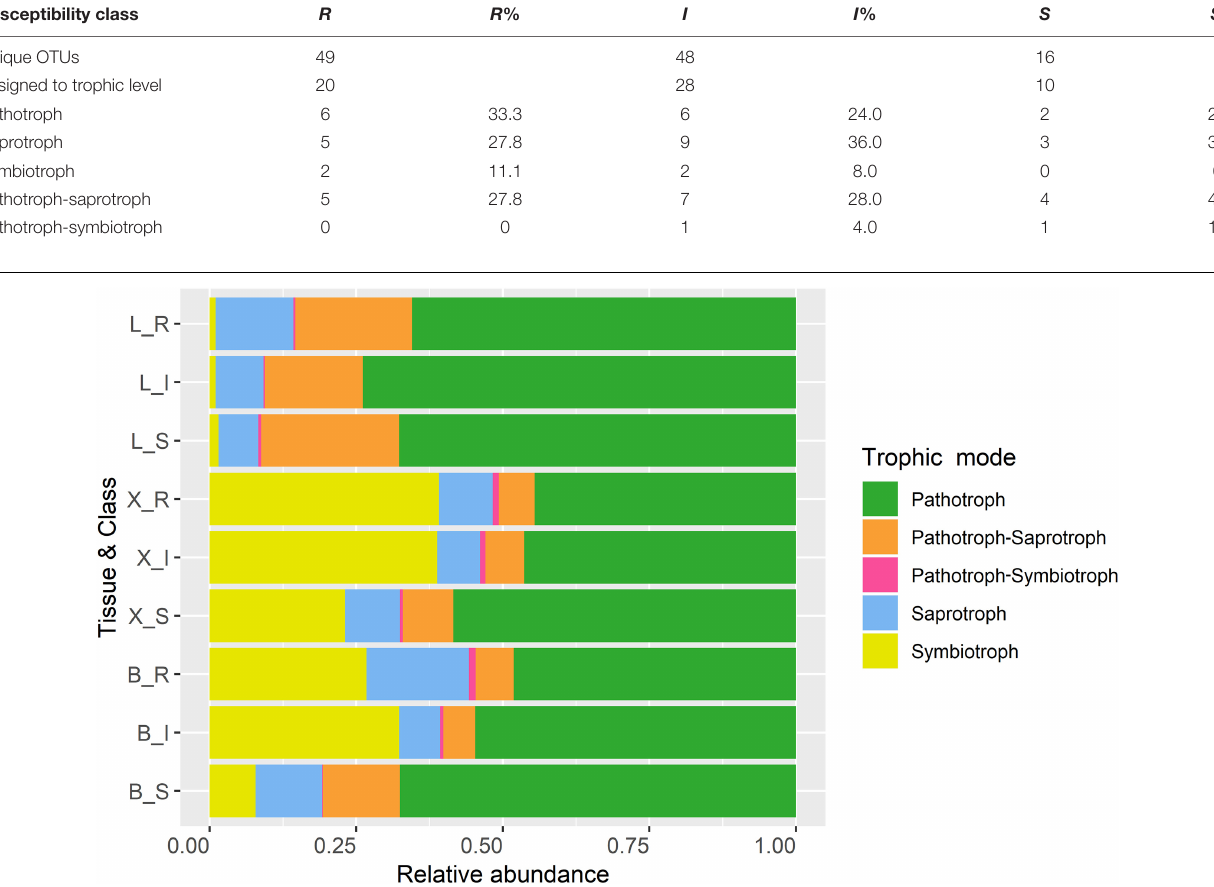
TABLE 6 | Number of OTUs exclusively assigned to each susceptibility class (R-resistant; I-intermediate; S-susceptible) and number of OTUs assigned to a trophic level and respective relative abundance for each class.